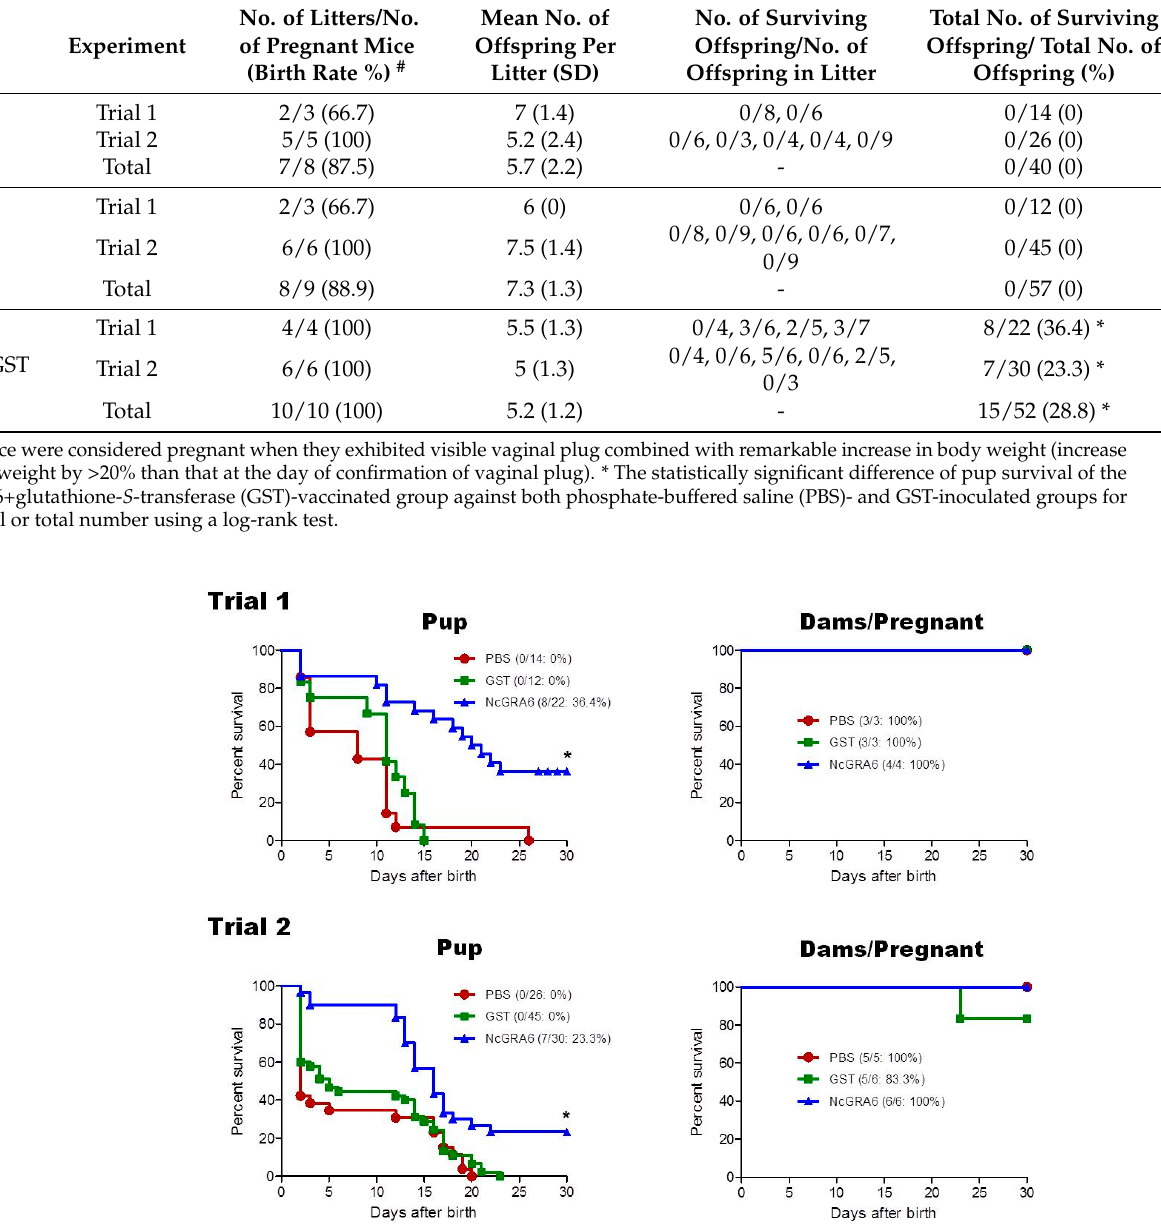
Figure 1. Protective efficacy in offspring and dams from immunized and control groups. Pregnant mice from three groups: PBS ( n = 3), GST ( n = 3), and NcGRA6 + GST ( n = 4) for trial 1, and PBS ( n = 5), GST ( n = 6), and NcGRA6 + GST ( n = 6) for trial 2 were intraperitoneally challenged with non-lethal dose (1 × 10 5 ) of N. caninum tachyzoites. Upper panel is survival rates of offspring and dams from trial 1, while lower panel is survival rates of offspring and dams from trial 2. The survival rates were calculated until 30 days after birth. Survival curves were generated with the Kaplan–Meier method. Significant differences between NcGRA6+GST-immunized offspring and both control groups according to the log-rank test (*; p <